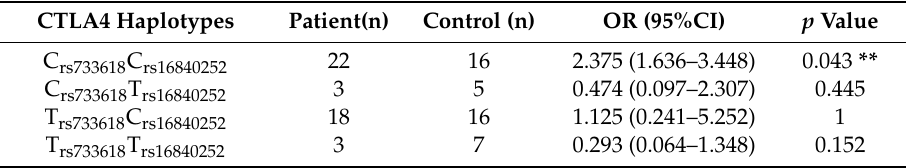
Table 5. CTLA4 haplotypes and odds ratio of developing Graves’ ophthalmopathy. CTLA4 Haplotypes Patient(n) Control